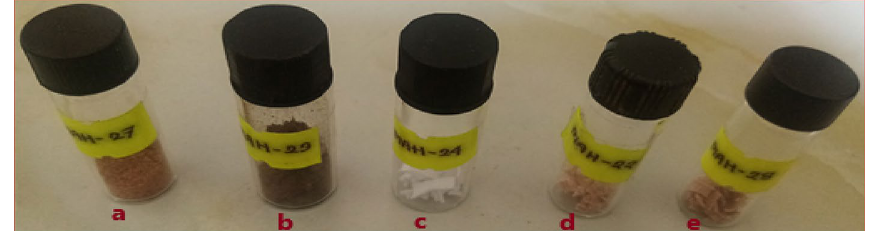
Figure 3. Samples of NPND-powdered materials ( a , b ); cut pieces of undyed cotton fabric ( c ) and cut pieces NPND-dyed cotton fabric ( d , e ) for measurement with sample port of UV–Vis–NIR